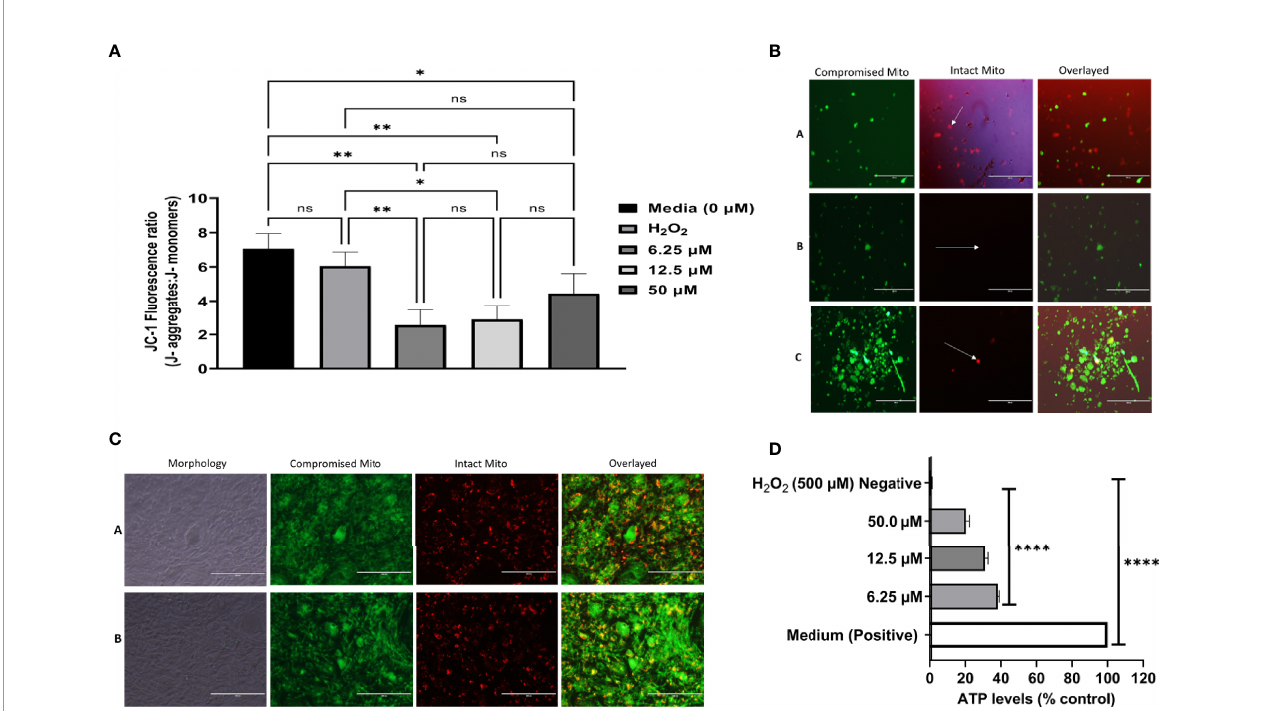
FIGURE 4 | (A) DHQ disrupts mitochondrial membrane potential in T. gondii tachyzoites. To evaluate the effect of DHQ in T. gondii tachyzoites mitochondria, extracellular parasites (10 5 /50 m L) were suspended with DHQ concentrations ranged from 6.25, 12.5 and 50 m M. Hydrogen peroxide (H 2 O 2 ) was used as a positive control. Data are presented as means plus standard errors of three different experiments performed in triplicate. * represent a signi fi cance difference between 50 m M relative to the control (p < 0.038). ** indicated a signi fi cant difference between 6.25, 12.5, m M DHQ relative to the control (0 m M) with (p < 0.002); Also, there was a signi fi cant difference between H 2 O 2 versus 6.25 (p < 0.0079), H 2 O 2 versus 12.5 m M DHQ (p = 0.014); ns, indicates no signi fi cant difference between the controls and the treated. (B) Morphological changes of T. gondii tachyzoites exposure to DHQ for 8 hours. Brie fl y, 10 5 RH-wild type of T. gondii was puri fi ed with syringe and fi ltered with 3 m m fi lter. Next 50 m L of the parasites were seeded into black 96 well plates and the reactions were allowed for 8 hours at 37 °C at 5% CO of JC-1dye was added and covered with foil and incubated fi r 45 minutes followed by sequential centrifugation, and fl uorescence taken using EVOS FL Fluorescent